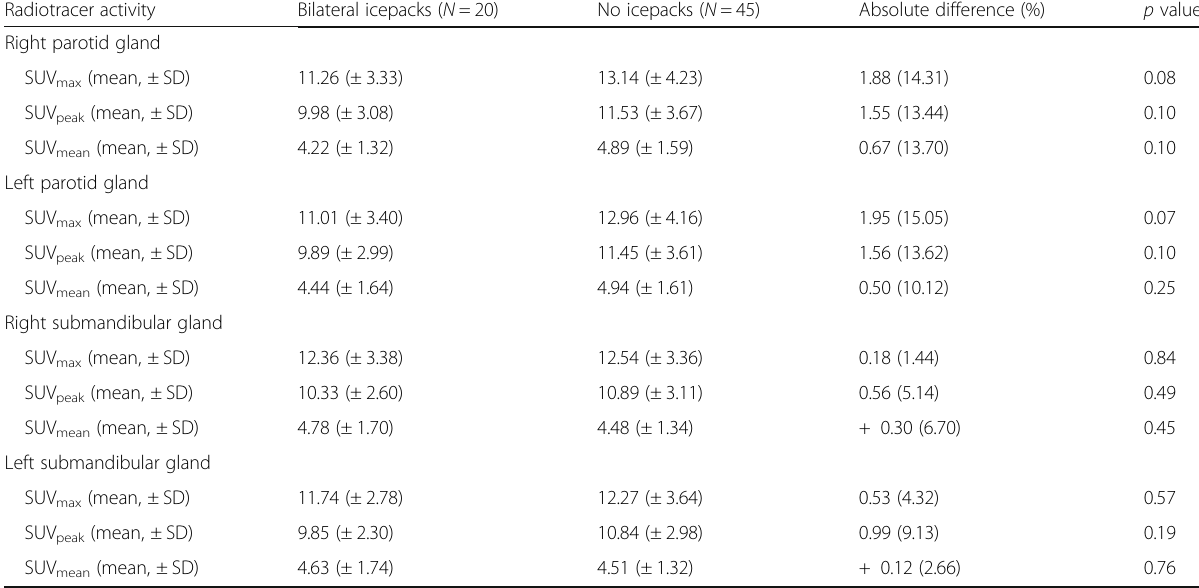
Table 3 Radiotracer activity in salivary glands of the bilateral icepack group versus the control group Radiotracer